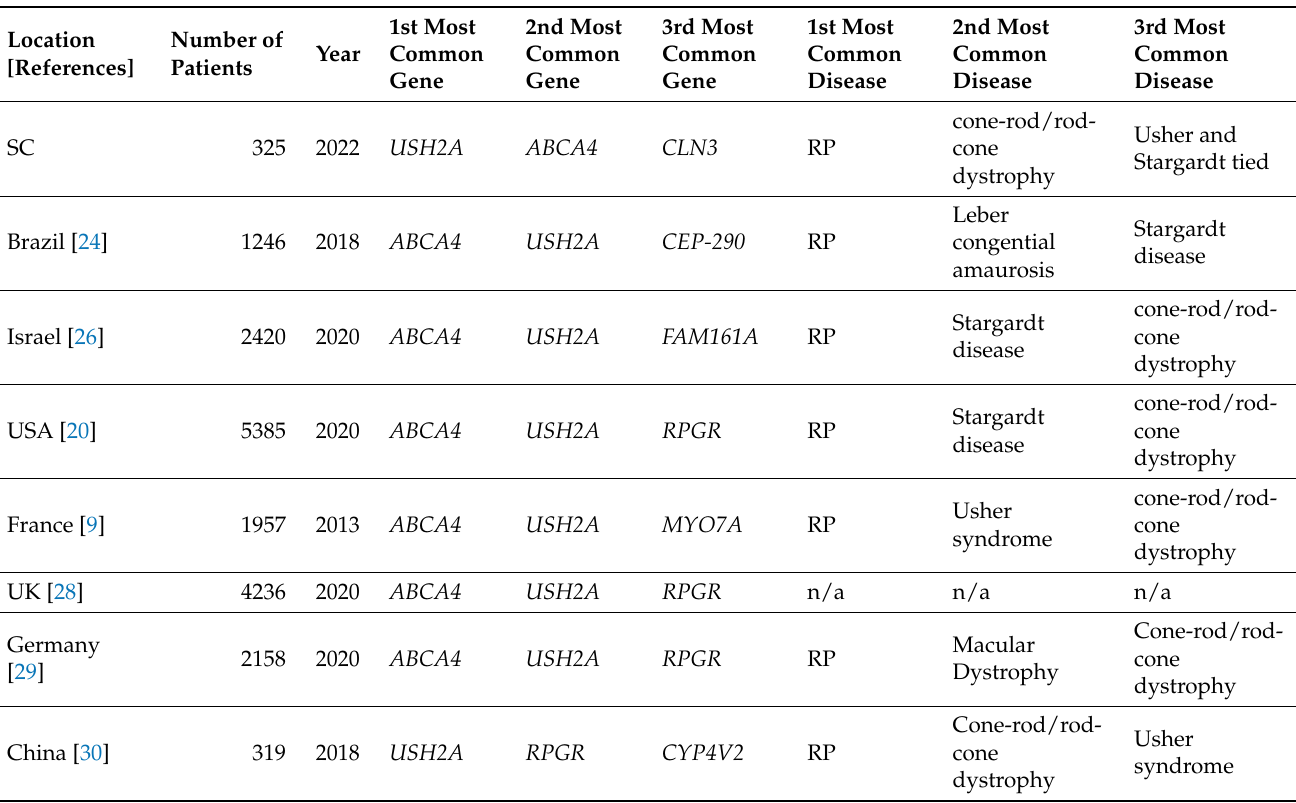
Table 4. Various international IRD cohorts and their most common genetic and diagnostic